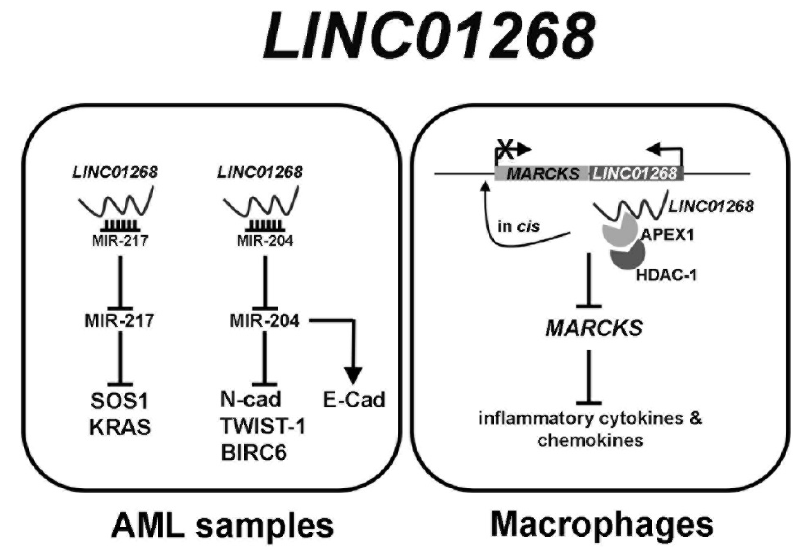
Figure 7. Graphical representation of LINC01268 regulatory network.